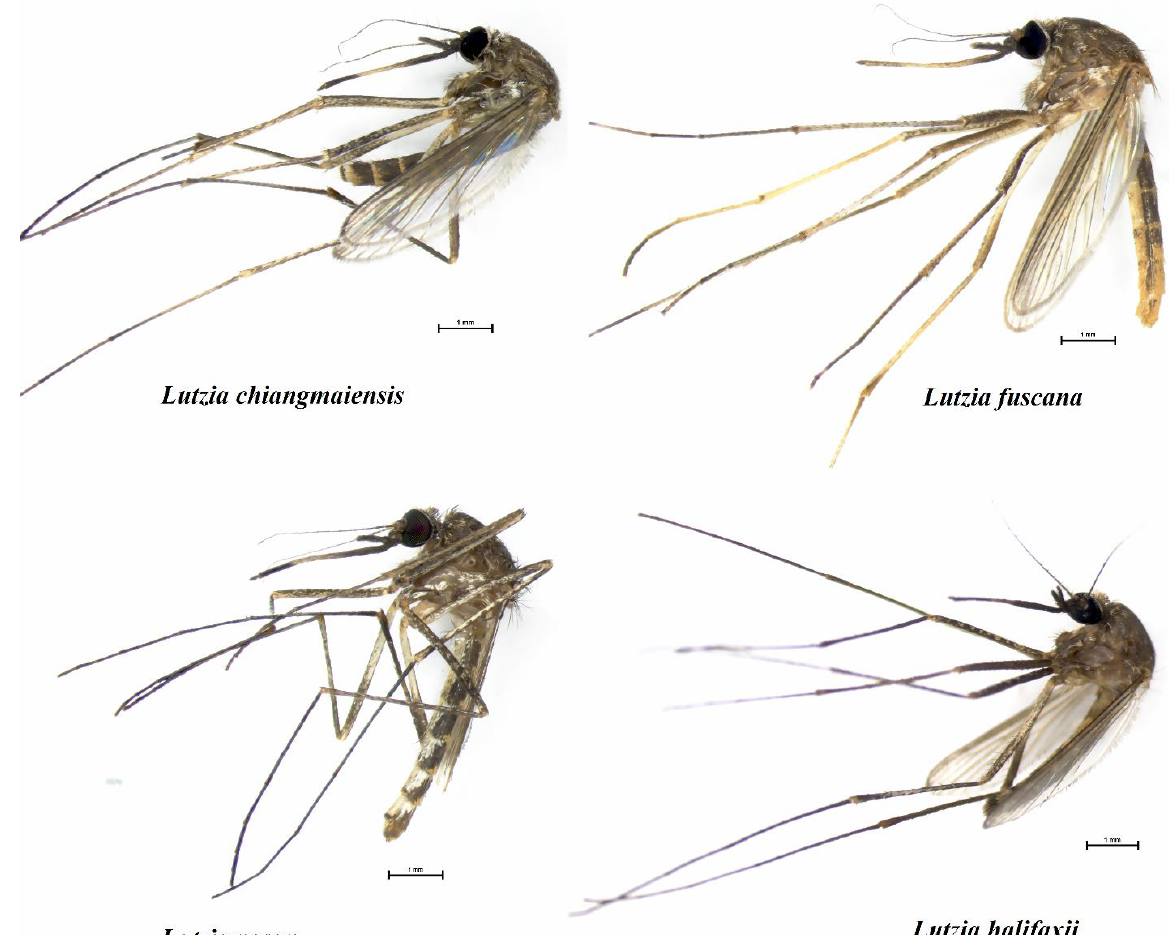
Figure 2. Four adult female Lutzia species used in the study: Lt. chiangmaiensis , Lt. fuscana , Lt. halifaxii , and Lt. vorax . Lutzia fuscana , Lt. halifaxii , and Lt. vorax have different abdominal terga characteristics: Lt. fuscana has entirely pale light-yellow scales on the terga V–VIII and entirely dark scales or narrow apical pale bands on the terga II–IV; Lt. halifaxii has fully covered dark scales on the abdominal terga and occasional lateral pale patches on the last few segments; Lt. vorax has apical pale stripes that are rather wide and around the same width; and Lt. chiangmaiensis has abdominal terga characteristics like those of Lt. vorax but with different wing vein positions.